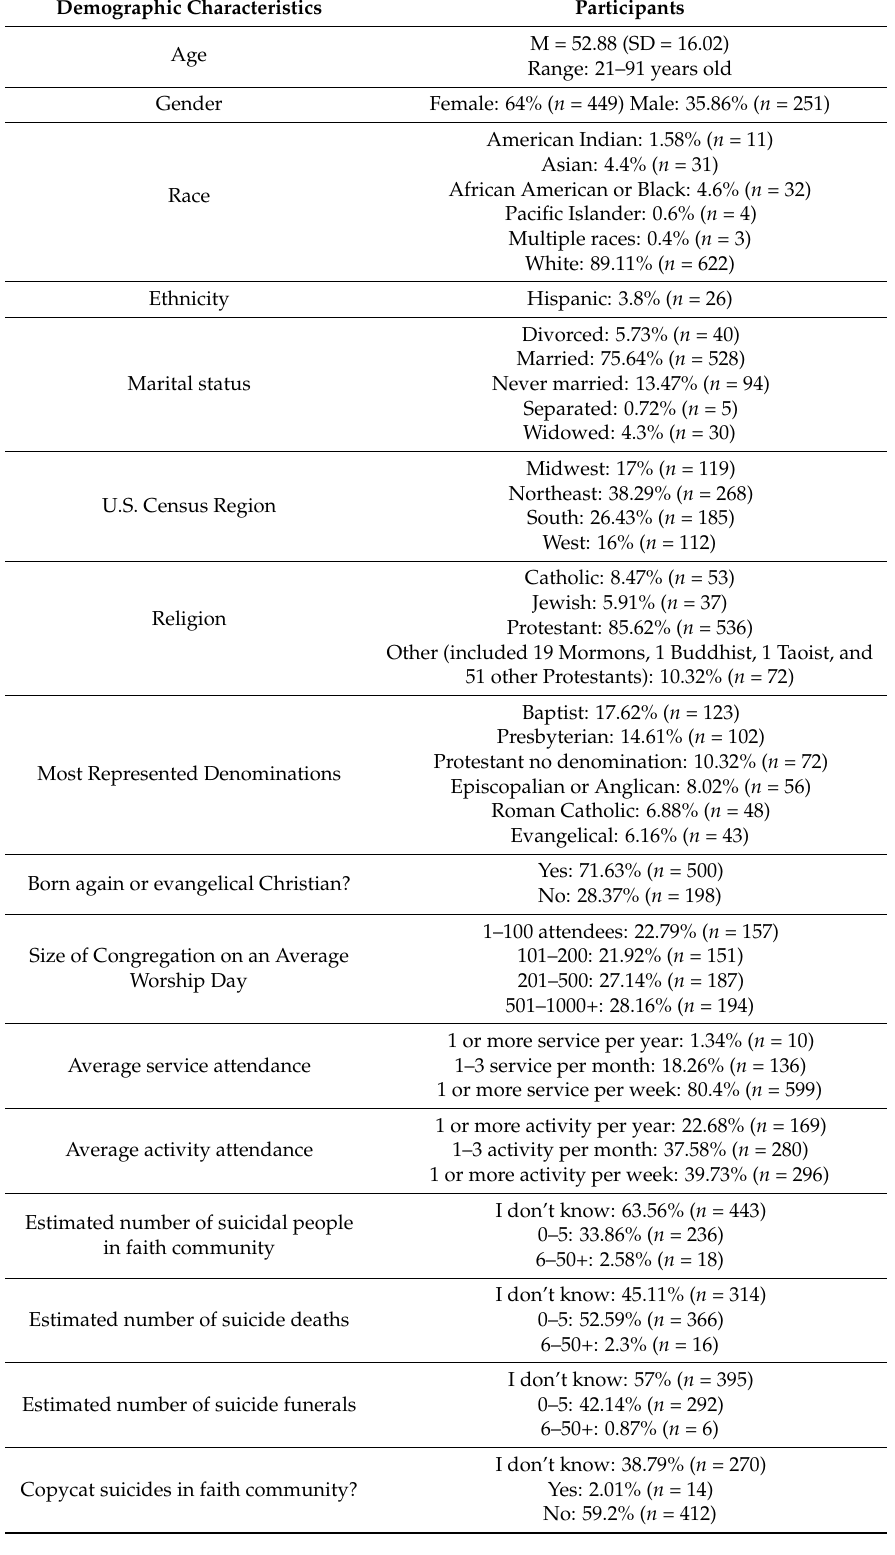
Table 1. Demographics of